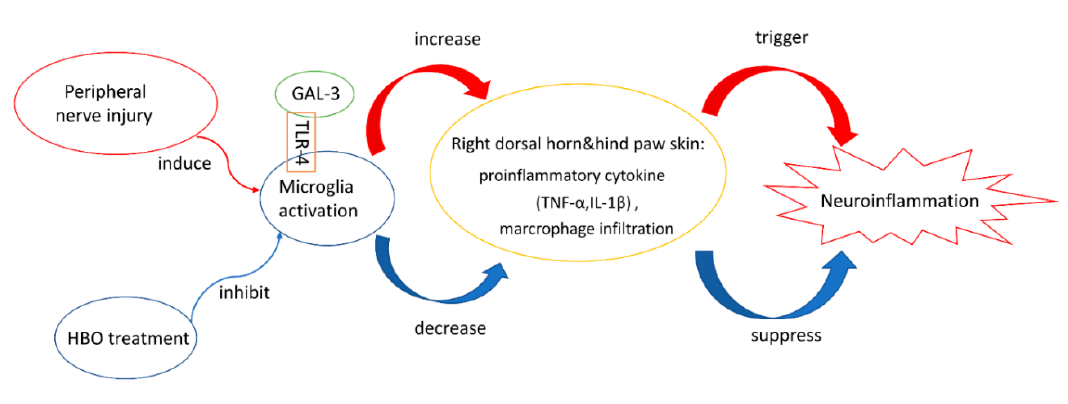
Figure 8. HBO treatment suppressed neuroinflammation by inhibiting the Gal-3-dependent TLR-4 pathway. HBO treatment inhibited GAL-3 and TLR-4 expression. Moreover, HBO treatment decreased proinflammatory cytokine expression and macrophage infiltration in the right dorsal horn and the right hind paw skin.